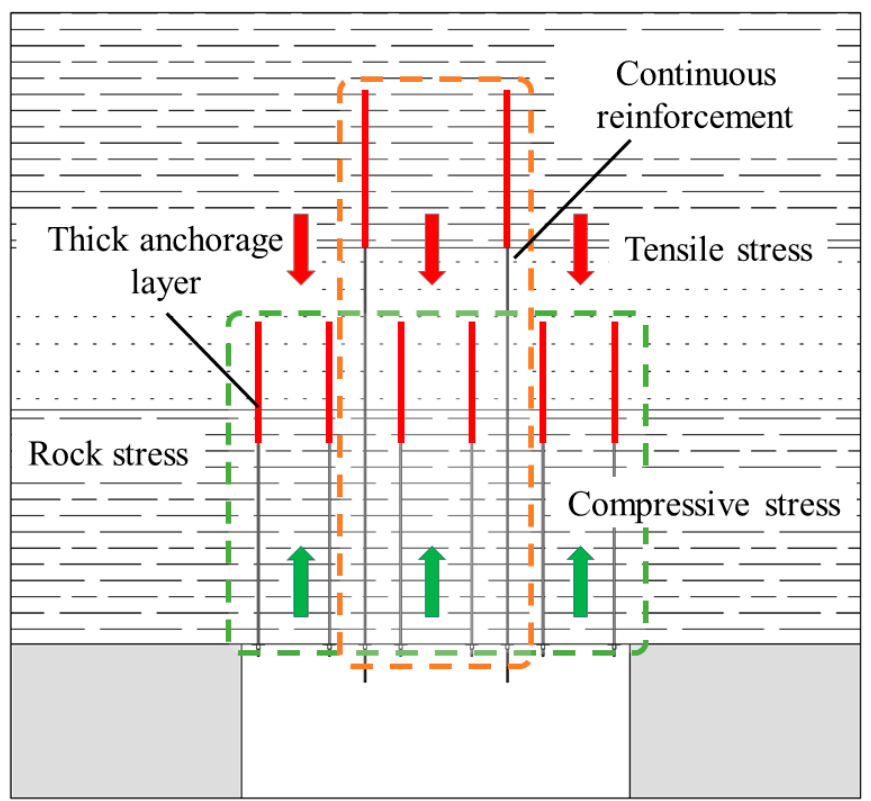
Figure 11. Schematic diagram for the continuous roof control.